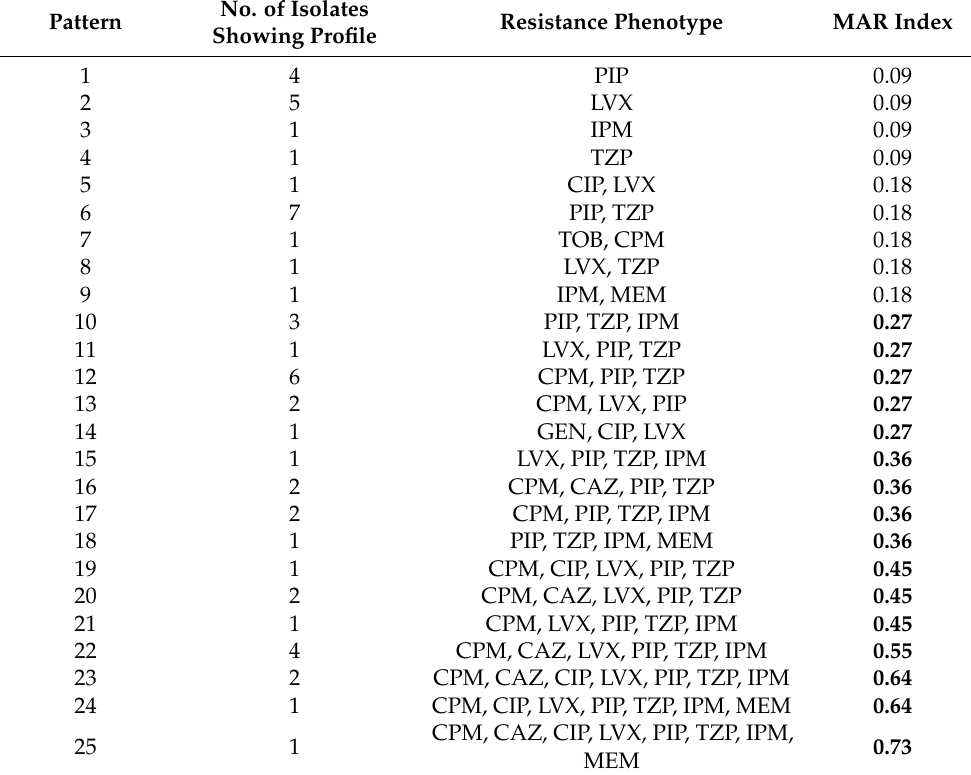
Table 4. P. aeruginosa isolate antibiotic-resistance profiles (no. 53) and MAR index. No. of Isolates Pattern Resistance Showing Profile